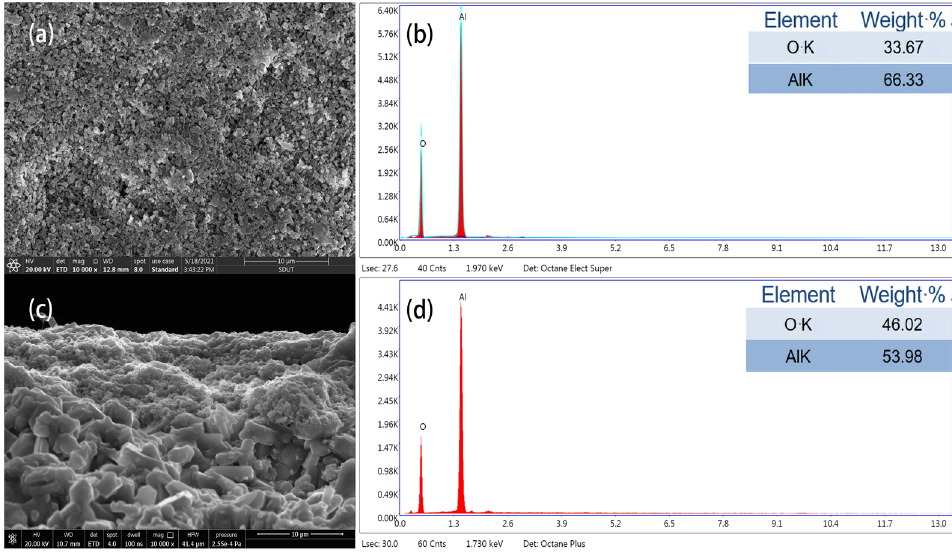
Figure 2. SEM and EDS images of the top section ( a , b ) and cross-section ( c , d ) of the ACMs. In order to investigate the surface wettability of ACMs, static water contact angle under air was measured. In Figure 3a,b, the water droplets diffused rapidly after 2 s through the surface of ACMs, perhaps due to the high-porosity surface and hydrophilicity of the packed Al 2 O 3 particles. In fact, in most cases, super hydrophilic surfaces also have underwater super oleophobic properties [22]. Water molecules are trapped in rough hydrophilic micro/nano structures with strong surface energy underwater, and oil droplets are excluded.